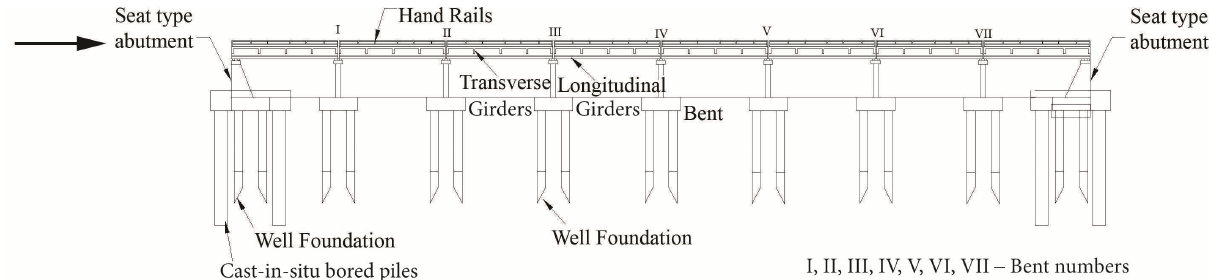
Fig. 3. Longitudinal elevation of the bridge